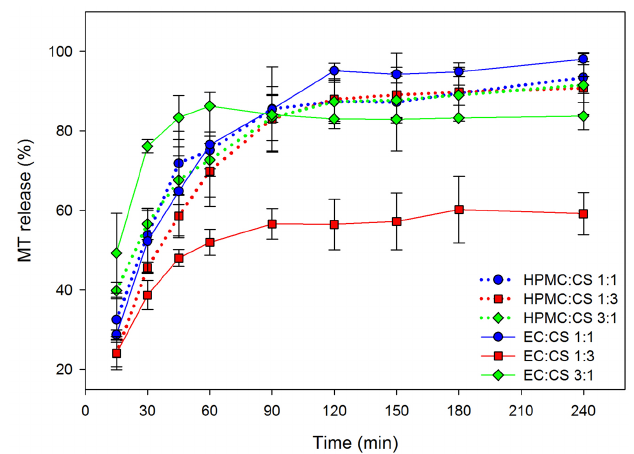
FIGURE 6 - Drug release profile of floating microparticles in simulated gastric fluid. MT: metronidazole; CS: chitosan; HPMC: hydroxypropyl methylcellulose; EC: